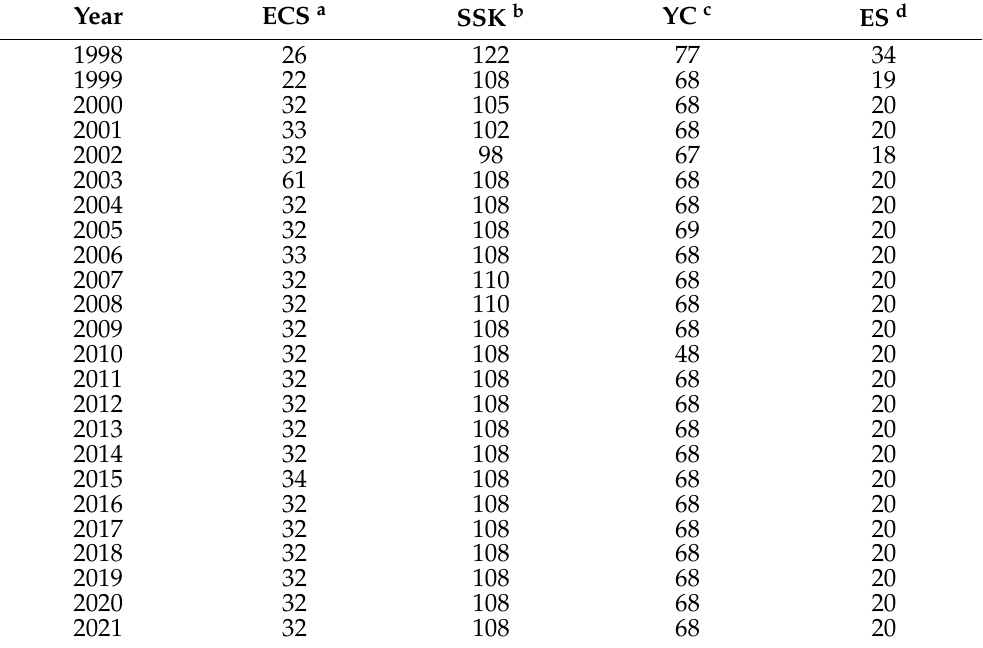
Table 1. The number of serial shipboard observations by Korean National Institute of Fisheries Science at the four regions from summertime (June to September) of 1998 to 2021. Among total 5488 data, about half (2421) data were matched with